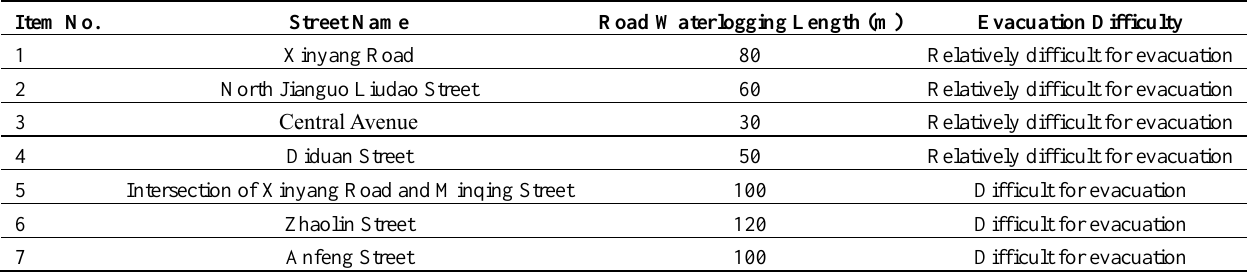
Table 4. Difficulty evaluation results of residents’ evacuation under the scenario of a 5-year frequency rainstorm.